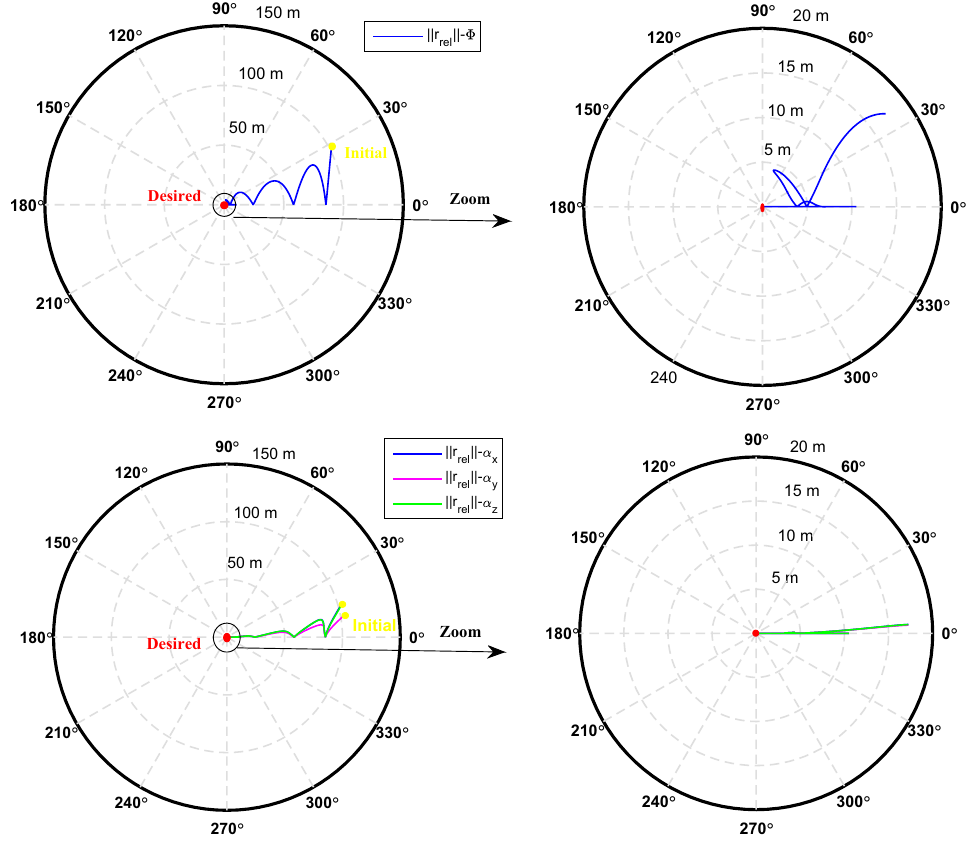
Figure 70. Relative pose trajectory in polar coordinate (Scenario